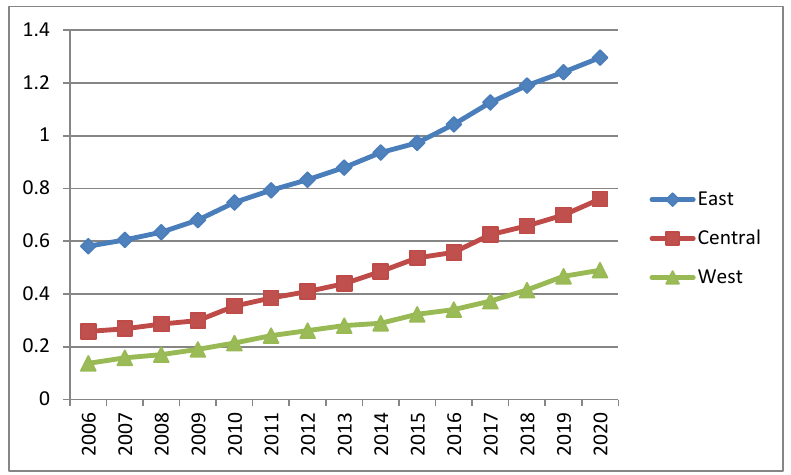
Figure 1. Trends of EE in the three regions.